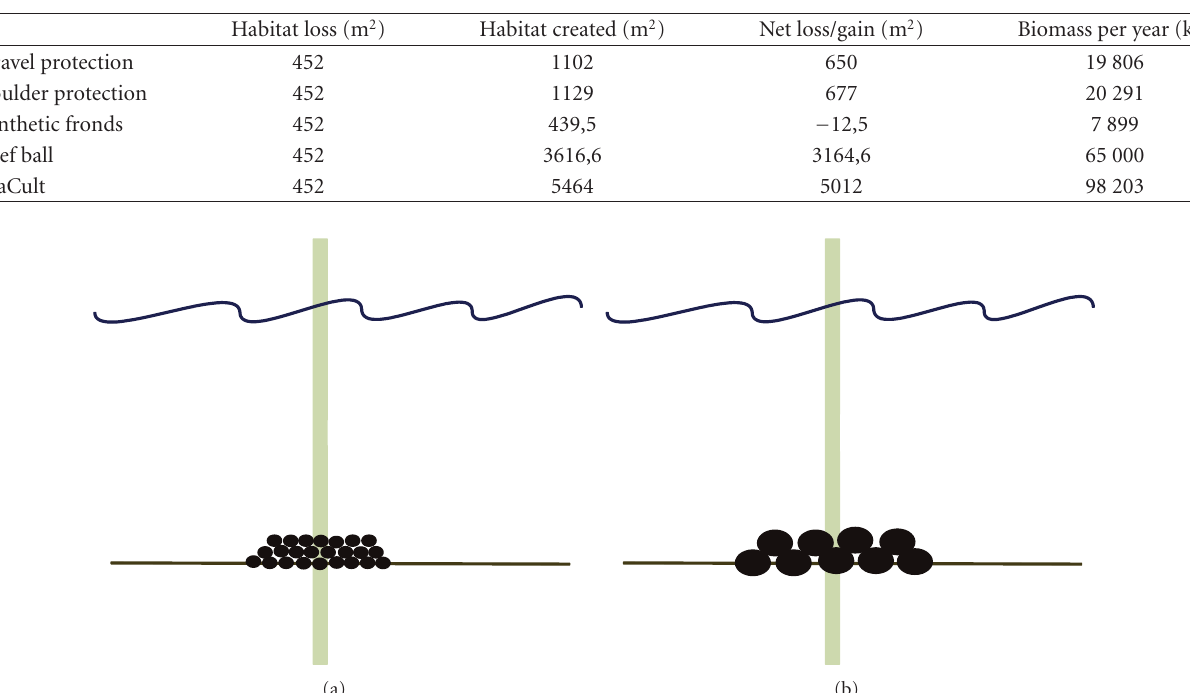
Figure 2: Illustrations of gravel (a) and boulder (b) protections around a monopile o ff shore wind power